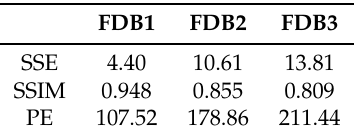
Figure 10. Ground-truth (GT) and results predicted by our model (Ours) and comparative models (PAIG, Eidetic 3D LSTM) from FDB1 to FDB3. Pred represents the frames predicted by the model, and Diff represents the difference between GT and Pred. The green area represents the correct part, and the red area represents the wrong part of the model’s prediction. PAIG receives four initial frames, and our model and Eidetic 3D LSTM receive two. Table 2. Errors according to the number of objects in